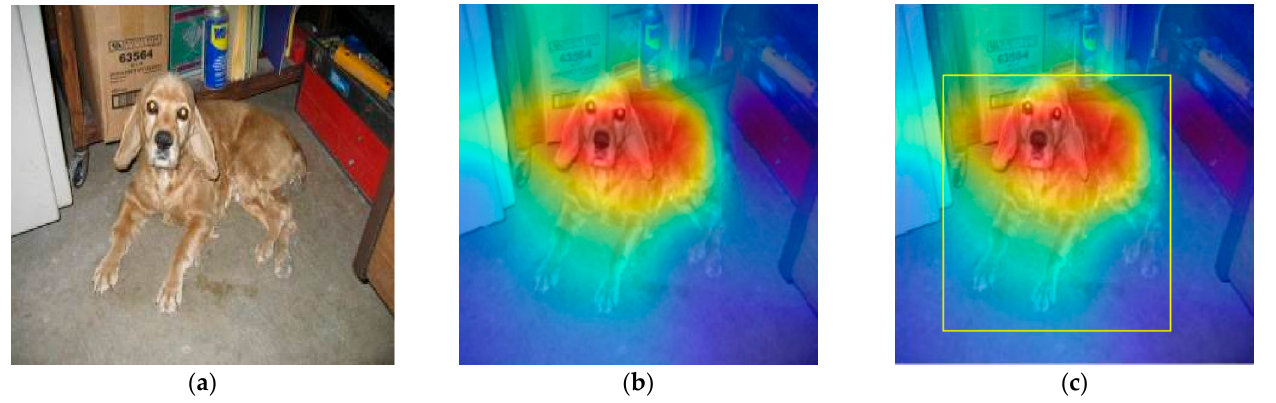
Figure 3. ( a ) Input image; ( b ) output of Grad-CAM++ shows that the Grad-CAM++ representations for ’feline tiger dog’; and ( c ) detected dog using Mask R-CNN shows that the recognized canine utilizing the proposed system